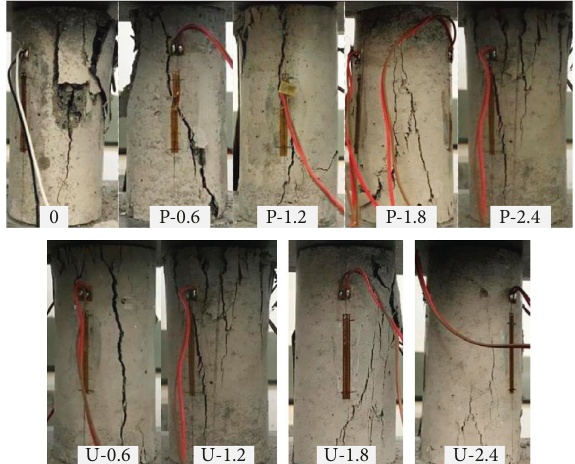
Figure 9: Concrete failure modes of each group under static